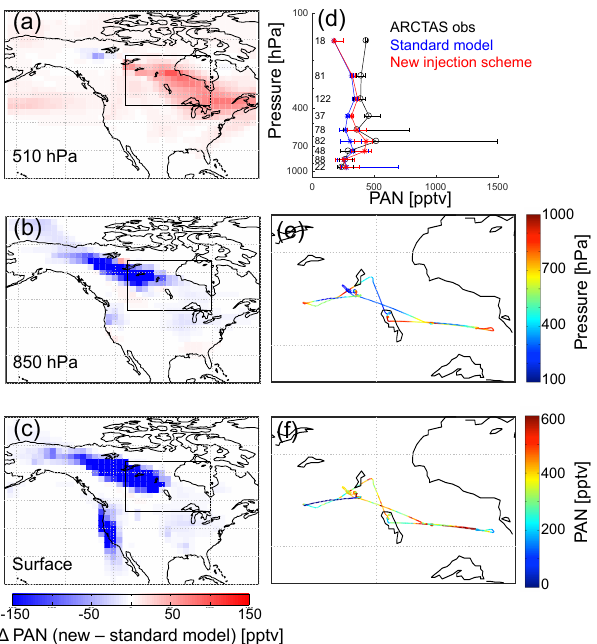
Figure 7. Same as in Fig. 5 but for 4 July 2008. The pink profiles are from a simulation that also increased the emissions of CO from boreal fires as described in Sect. 2.4. The green profiles are from a simulation of the standard model, with increased CO emissions as the pink